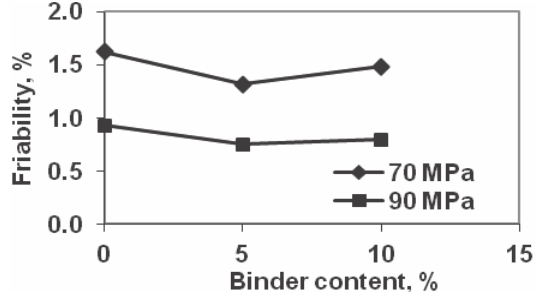
Fig. 5 Friability of tablets. Table 5 Indentation hardness of tablets made from dry powder formulations at 70 and 90 MPa compression pressure and different binder